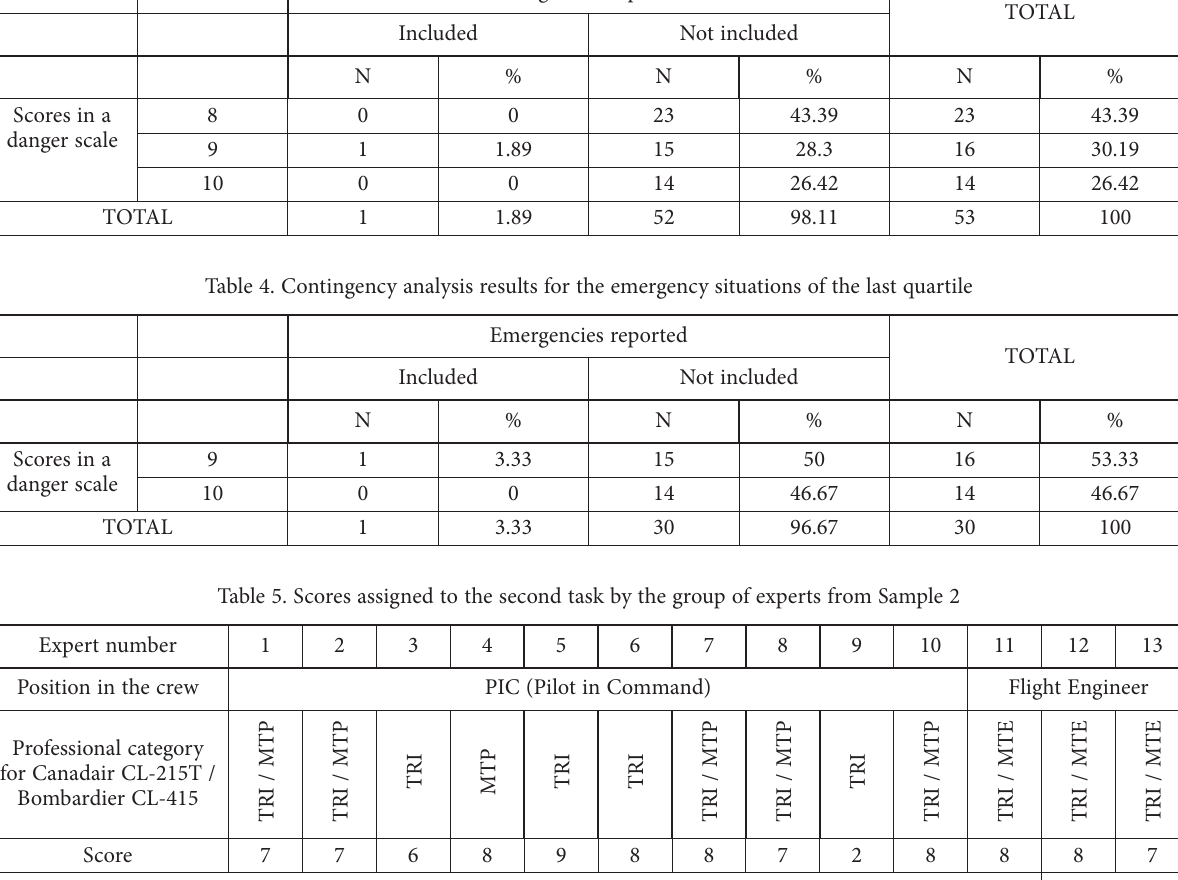
Table 3. Contingency analysis results for the emergency situations above the 55 th percentile Emergencies reported